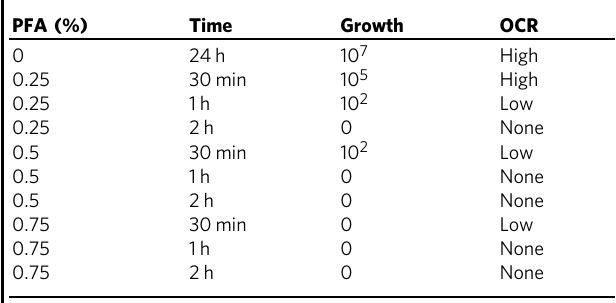
Table 1 Growth and metabolism of PFA-treated